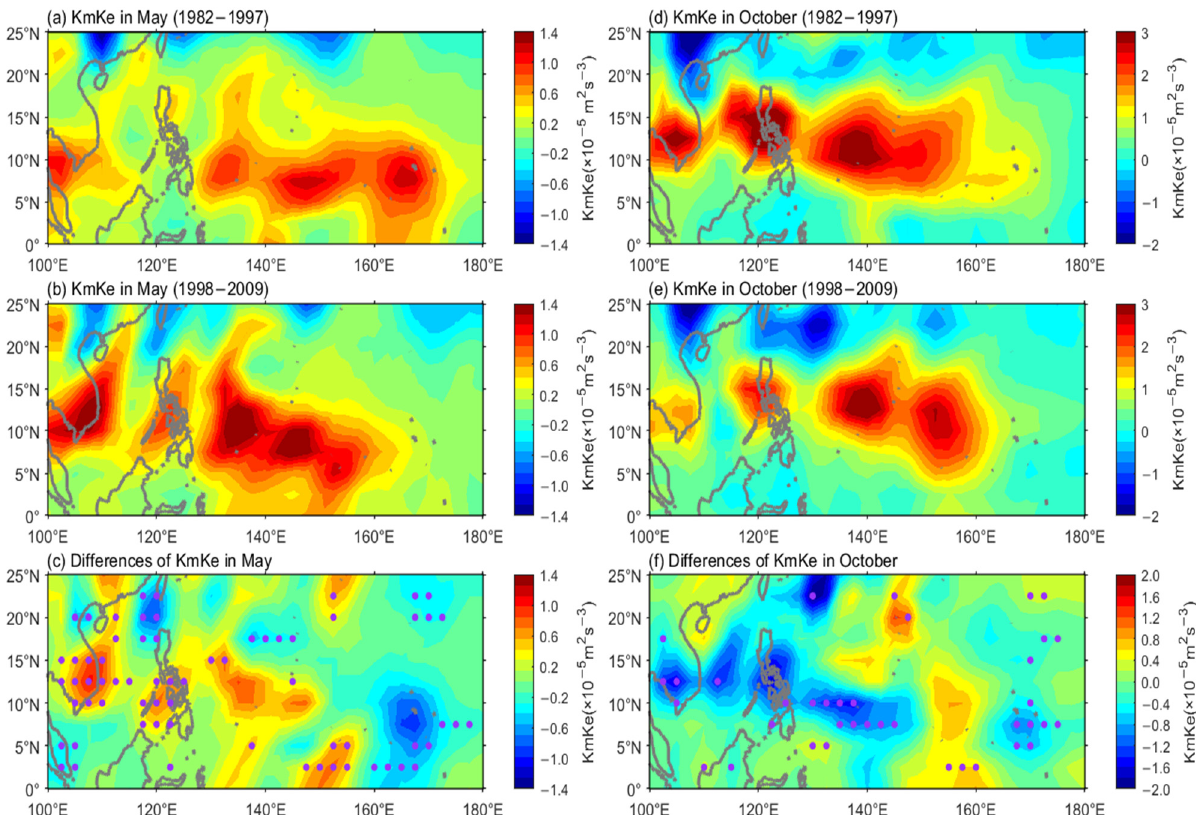
Figure 7. Comparisons of BEC term (KmKe) (shading) between two sub-periods in May ( a – c ) and October ( d – f ). Mean Kmke (shading) in May during ( a ) P1 (1982–1997) and ( b ) P2(1998–2009). ( c ) Differences of Kmke (shading) between P2 and P1 in May. As in ( a – c ), but for October ( d – f ). Signals above the 90% confidence level are highlighted by purple dots.